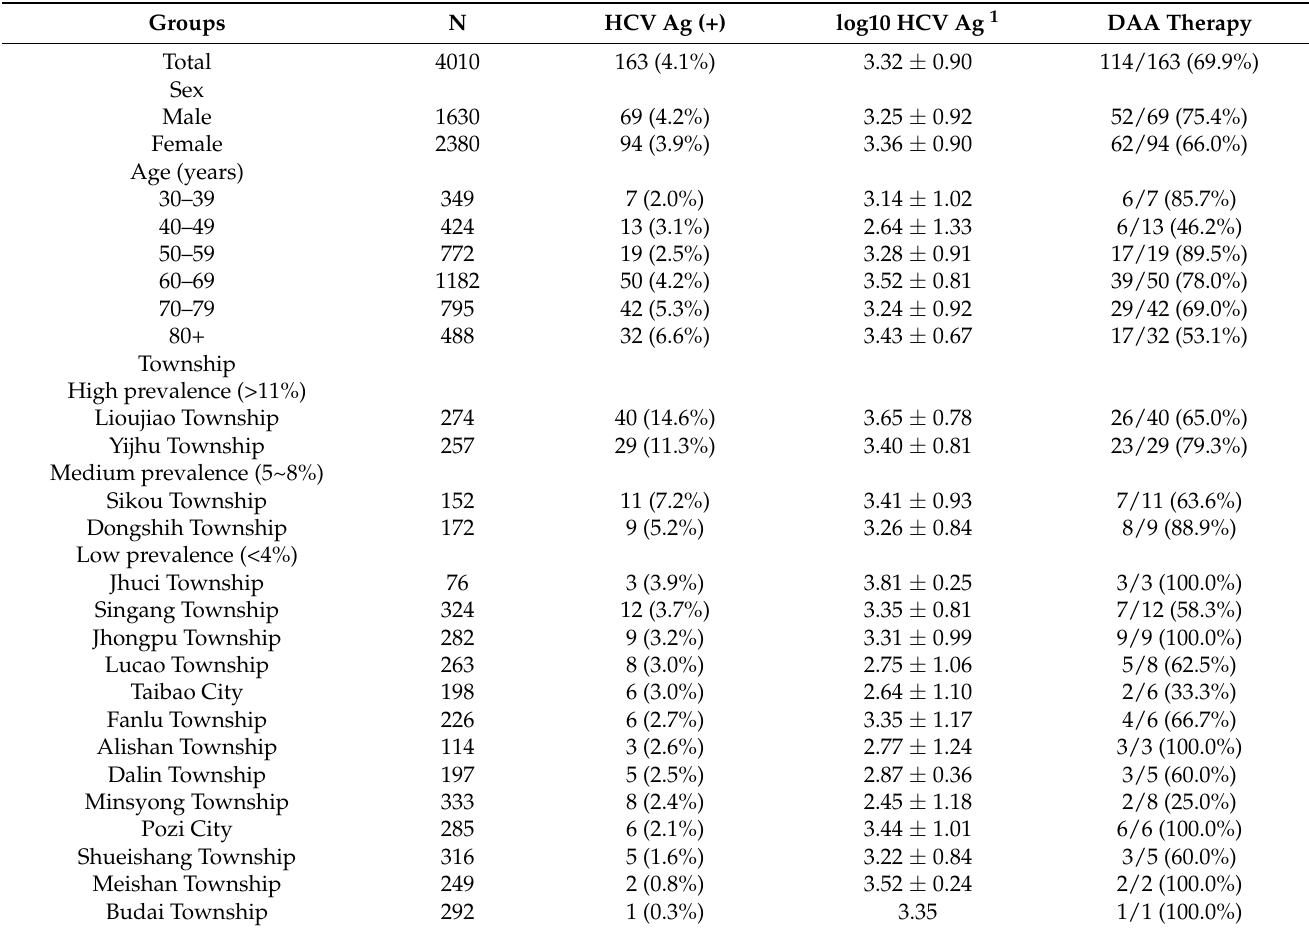
Table 2. Prevalence and mean logarithmic concentrations of HCV Ag and treatment rates of direct- acting antiviral agents (DAA) grouped by sex, age, and